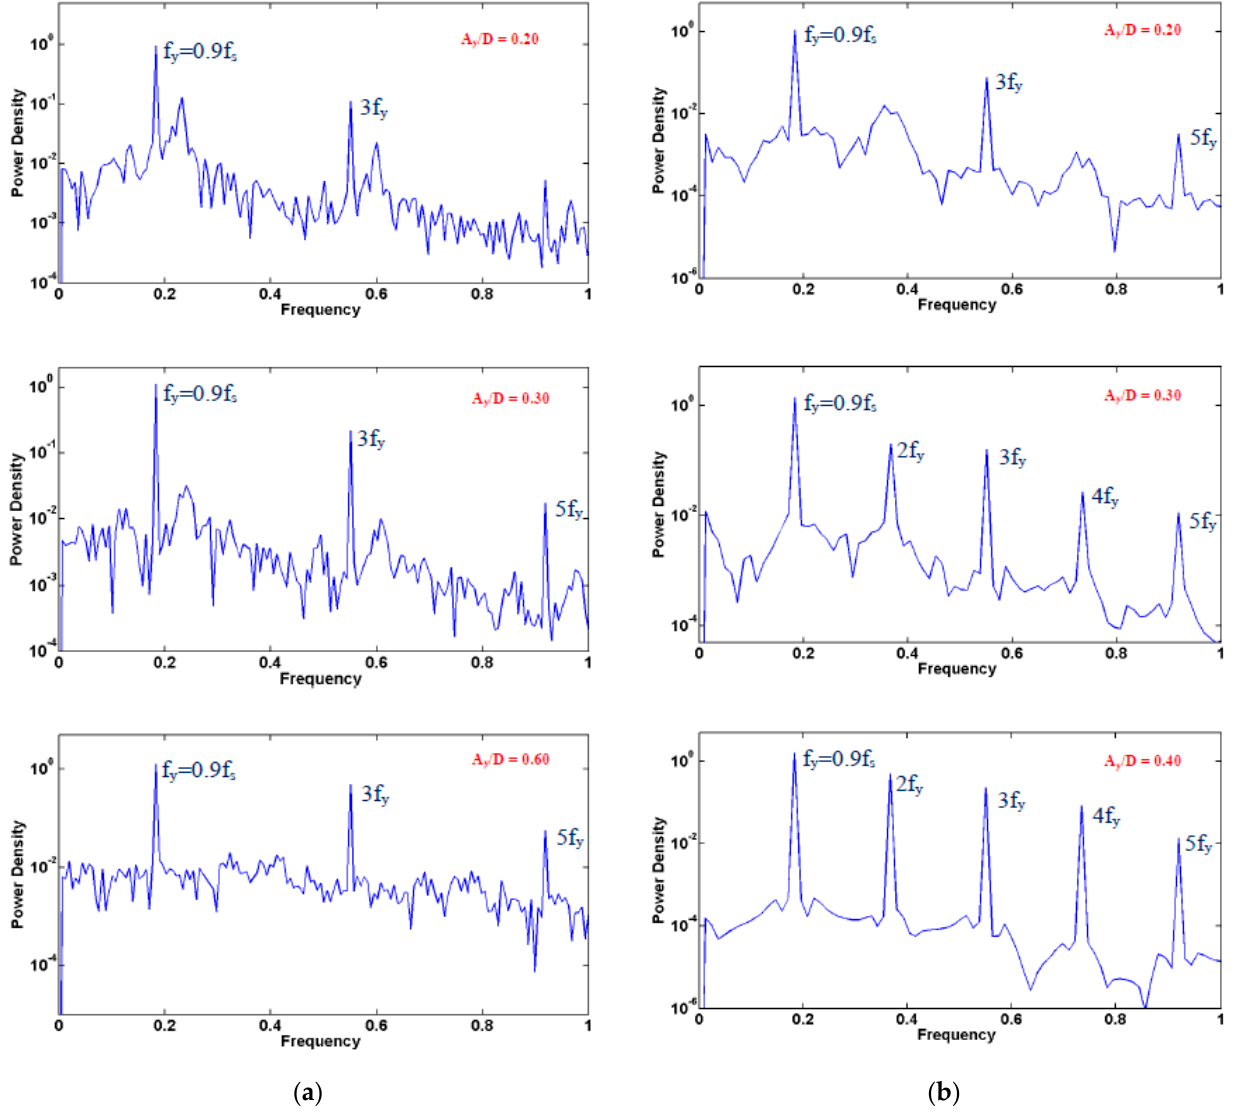
Figure 7. Spectra of the lift force coefficient for F = 0.9: ( a ) counter-clockwise cylinder oscillation, ( b ) clockwise cylinder oscillation.